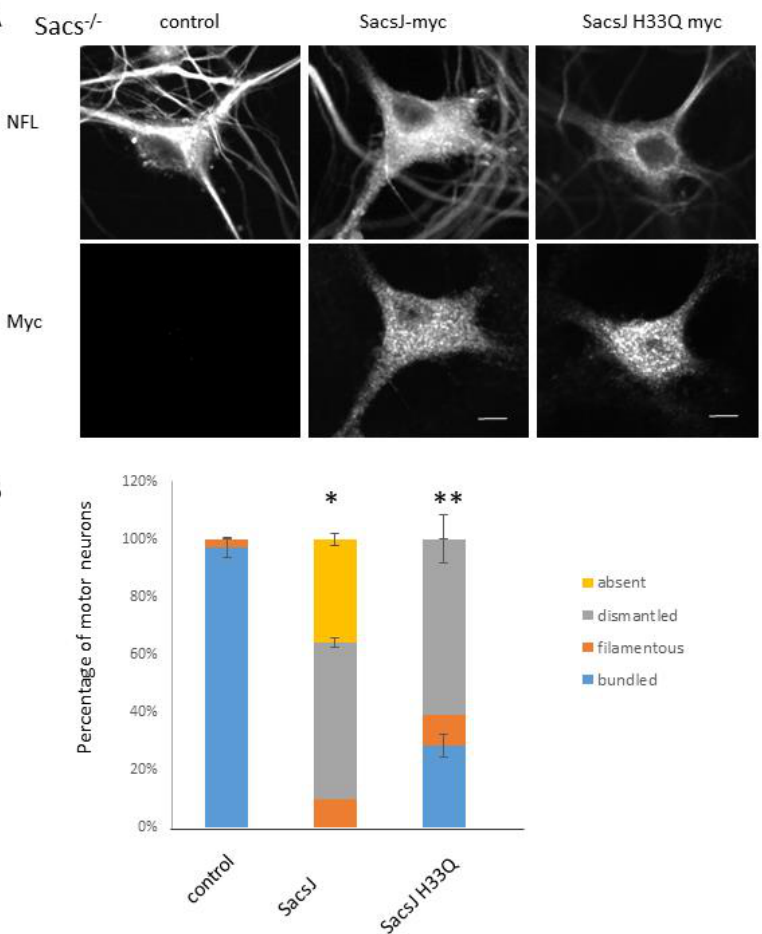
Figure 9. SacsJ acts independently to disassemble NF, but requires Hsp70 to degrade NFL. SacsJ- or SacsJH33Q-myc, a variant unable to bind HSP70, were expressed in motor neurons in Sacs − / − 6 week-old spinal cord-DRG cultures. ( A ) Representative 3-dimensional reconstructions of Z-stack confocal images of motor neurons double labelled with anti-myc (rabbit anti-myc) and anti-NFL to show the NF network and expression of NFL. The NF network was dismantled or absent when SacsJ-myc was expressed while SacsJH33Q-myc only dismantled NF network. Scale bar: 10 µm. ( B ) Quantitation of the percentage of motor neurons presenting a filamentous, bundled, dismantled or no NF network when expressing SacsJ-myc or SacsJH33Q-myc. * p < 0.05 vs. control, ** p < 0.05 vs. SacsJ using a one-way ANOVA, HSD Tuckey post hoc analysis ( n = 3).